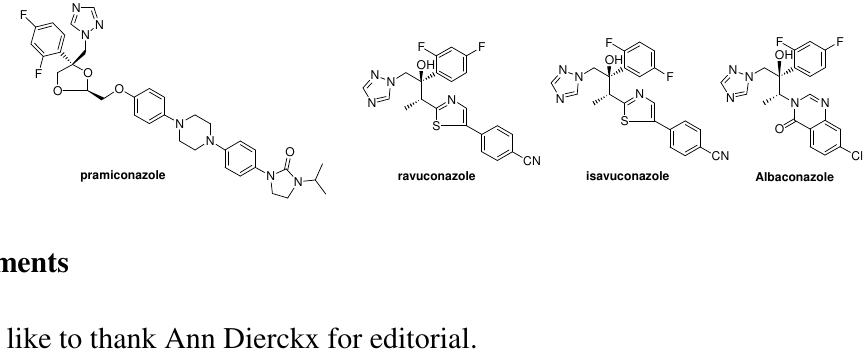
Figure 10. Emerging conazoles under clinical evaluation for systemic fungal